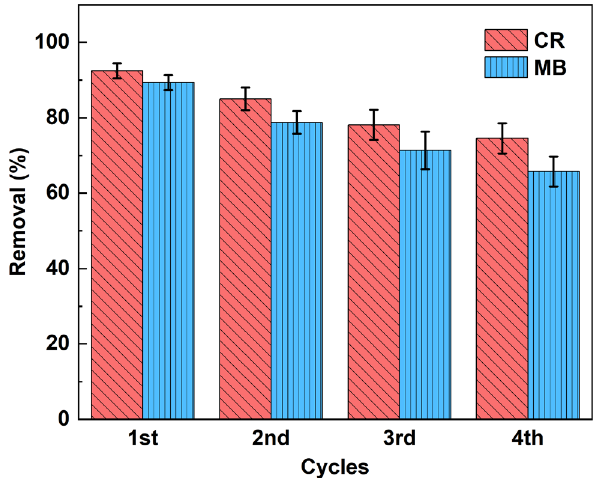
Figure 10. Cyclic adsorption of CaCO 3 @STA/PAM/TOCN aerogels (reusability experiments were performed at pH 7.0 with a dose of 10 mg of CaCO 3 @STA/PAM/TOCN, an elution volume of 25 mL at 20 °C, an initial CR dye concentration of 100 mg/L, an initial MB dye concentration 4 mg/L. After each elution, the aerogels were freeze- dried at −40 °C ).